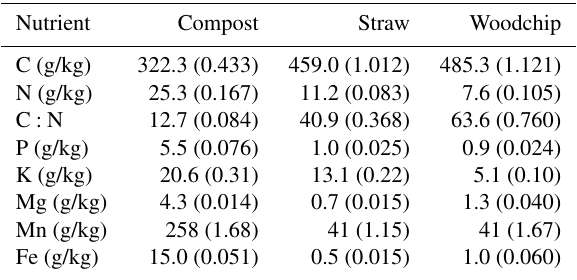
Table 2. Residue characterisation. Numbers in parenthesis repre- sent the standard error of the mean (SEM; n = 3). Nutrient